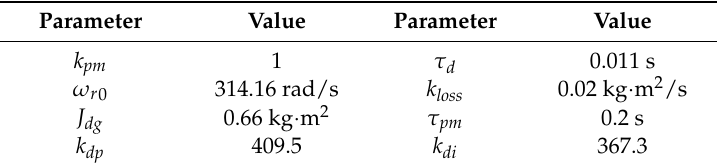
Table 1. The main parameters of the diesel generator set (DGS).